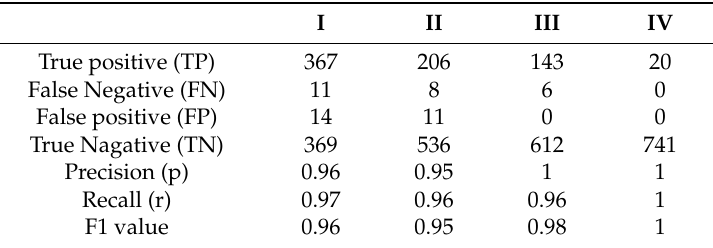
Table 5. Analysis of Early Warning Results of VPWS - MBD